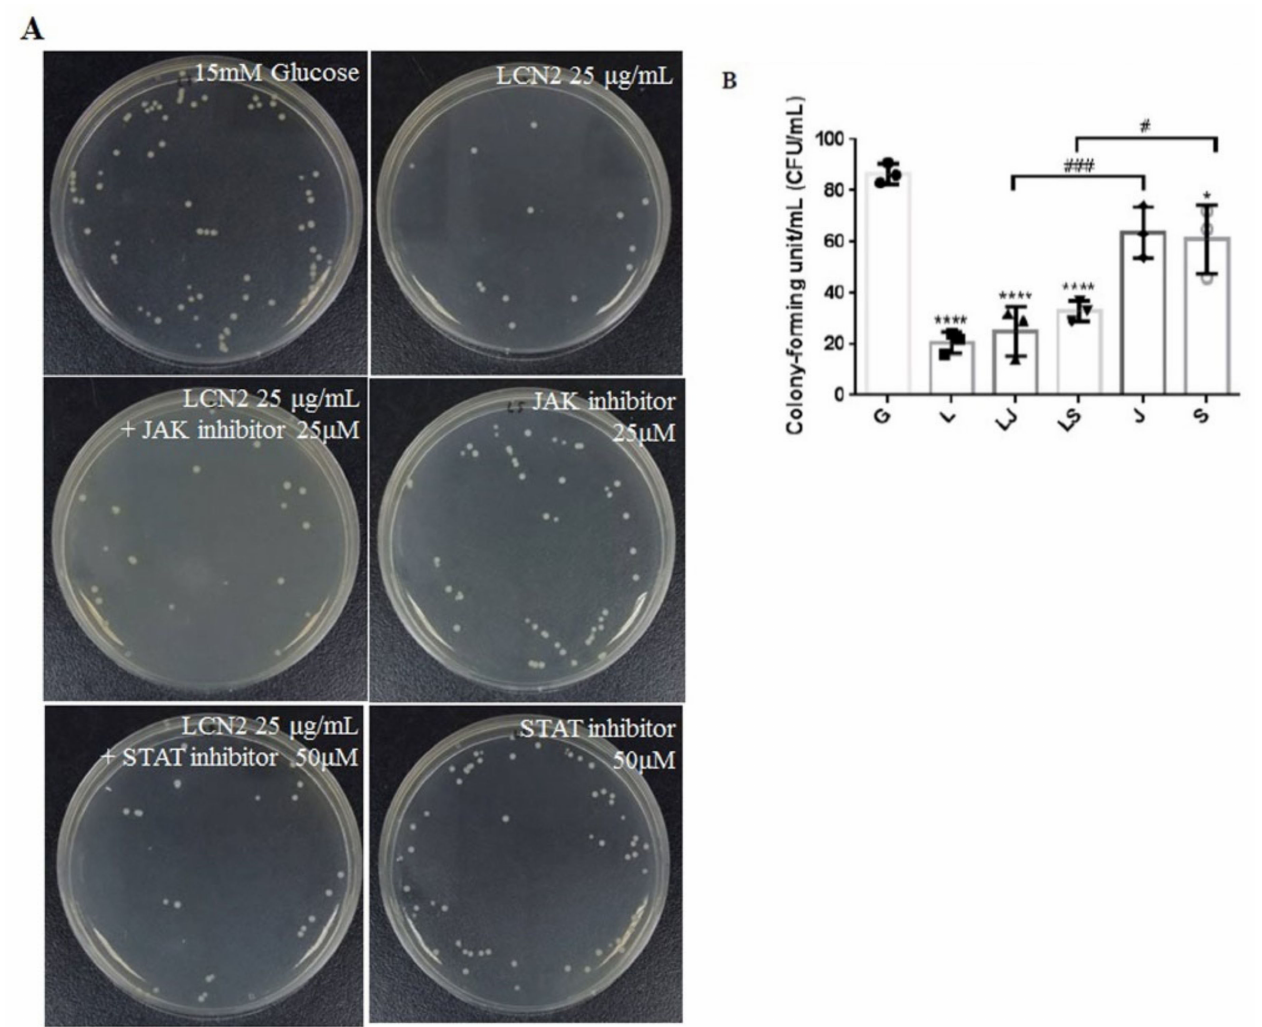
Figure 7. JAK and STAT inhibitors do not affect LCN2 suppression in UPEC-infected bladder cells in a high-glucose environment. SV-HUC-1 cells were pretreated with a 25 µ M JAK inhibitor (LJ) or a 50 µ M STAT inhibitor (LS) and 15 mM glucose for 24 h before a 25 µ g/mL LCN2 pretreatment followed by UPEC infection (MOI of 100), as described above. Cells pretreated with the 25 µ M JAK inhibitor (J) or STAT inhibitor (S) alone for 24 h followed by UPEC infection were used as respective controls. Cells pretreated with 25 µ g/mL LCN2 alone (L) followed by UPEC infection were used as other controls. Cells infected with 15 mM glucose and UPEC alone were used as the respective positive controls (G). The picture shown is representative of a typical result. Twenty-four hours postinfection, all infected cells were ( A ) lysed and plated on LB agar and ( B ) measured using ImageJ software to analyze UPEC colonization. Colony-forming units/ml (CFUs/ml) were acquired after plating 10-fold dilutions of infected cells with lysis. The data are expressed as means ± SDs of three separate experiments. An analysis of variance was used to evaluate differences between various treatment groups and controls. Statistical differences between groups were determined using the Mann–Whitney U Student’s t -test. Statistical significance was set at p < 0.05. * p < 0.05, **** p <0.0001 compared to the positive control groups. # p < 0.05, ### p < 0.001 for comparisons between the two indicated